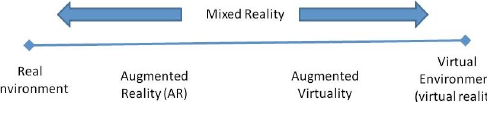
Figure 1. Simple representation of a Reality-Virtuality